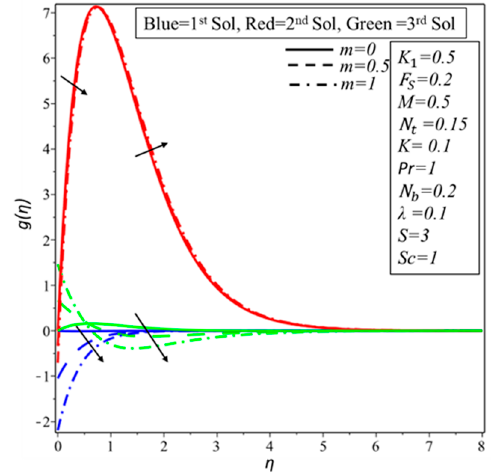
Figure 9. Microrotation profiles for increasing values of m .